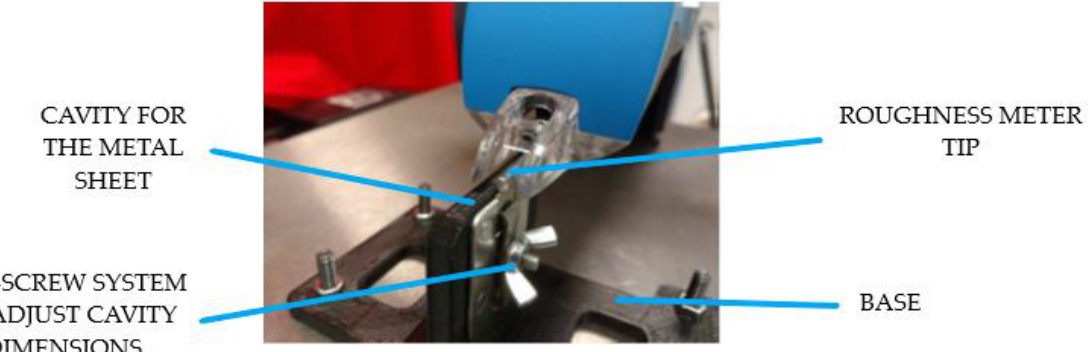
Figure 2. Support used to fix the parts and roughness meter.